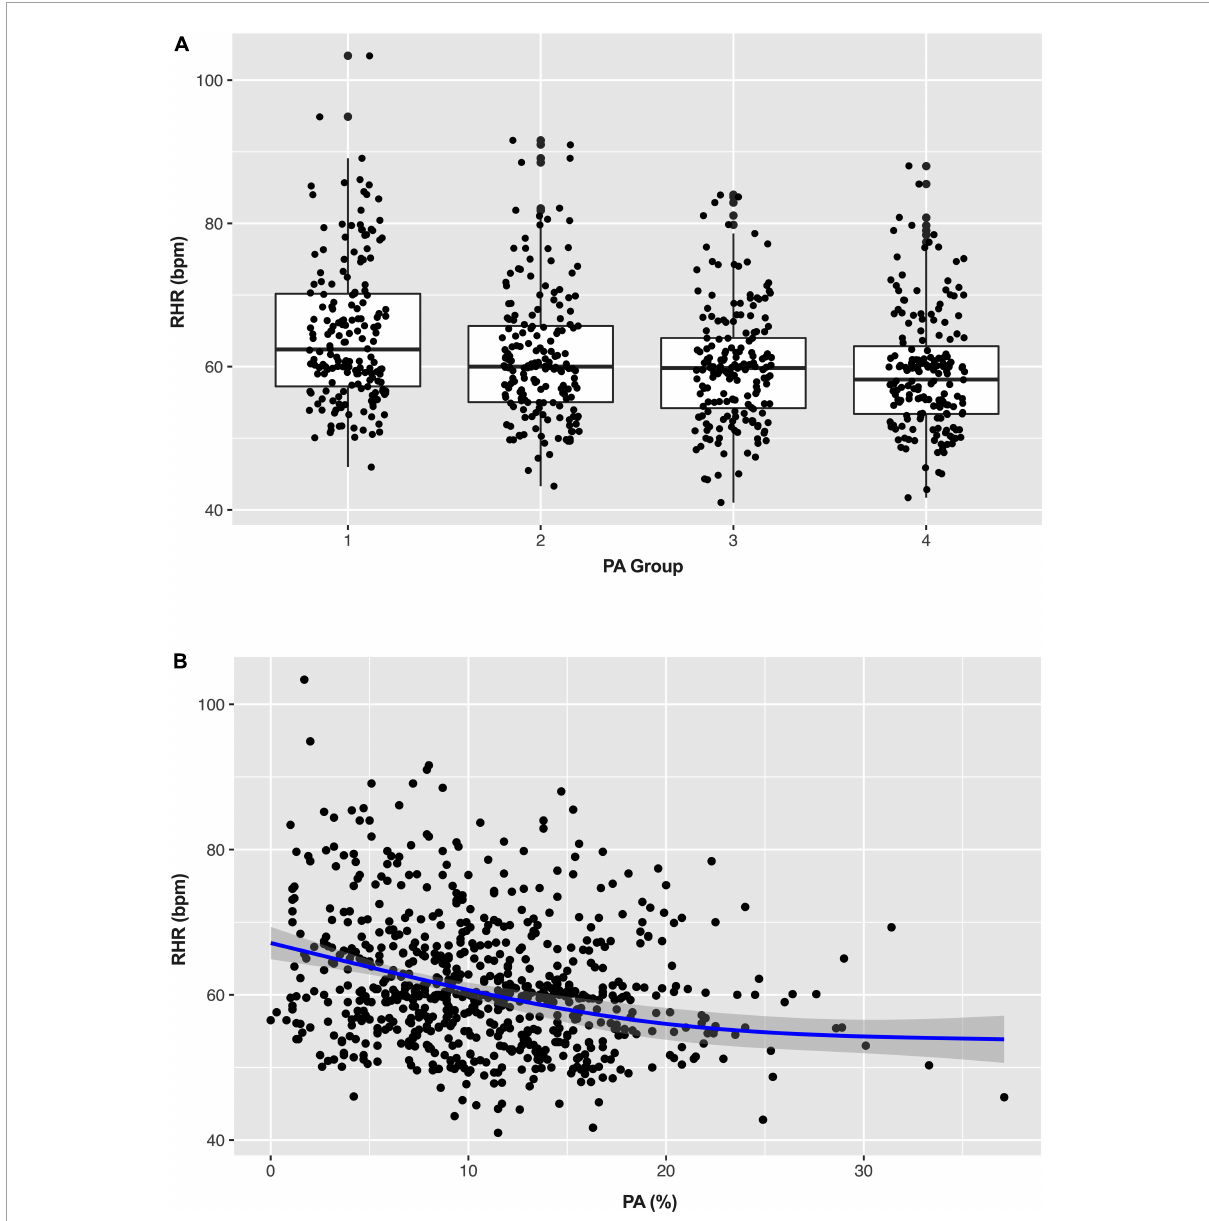
Estimated survival by the Kaplan-Meier method for the entire cohort stratified by quartile of daily PA ( Figure 4A ) and RHR ( Figure 4B ), respectively. In univariable Cox regression analyses, both daily PA and RHR by quartile were significantly associated with survival ( Table 2 ). In univariable Cox